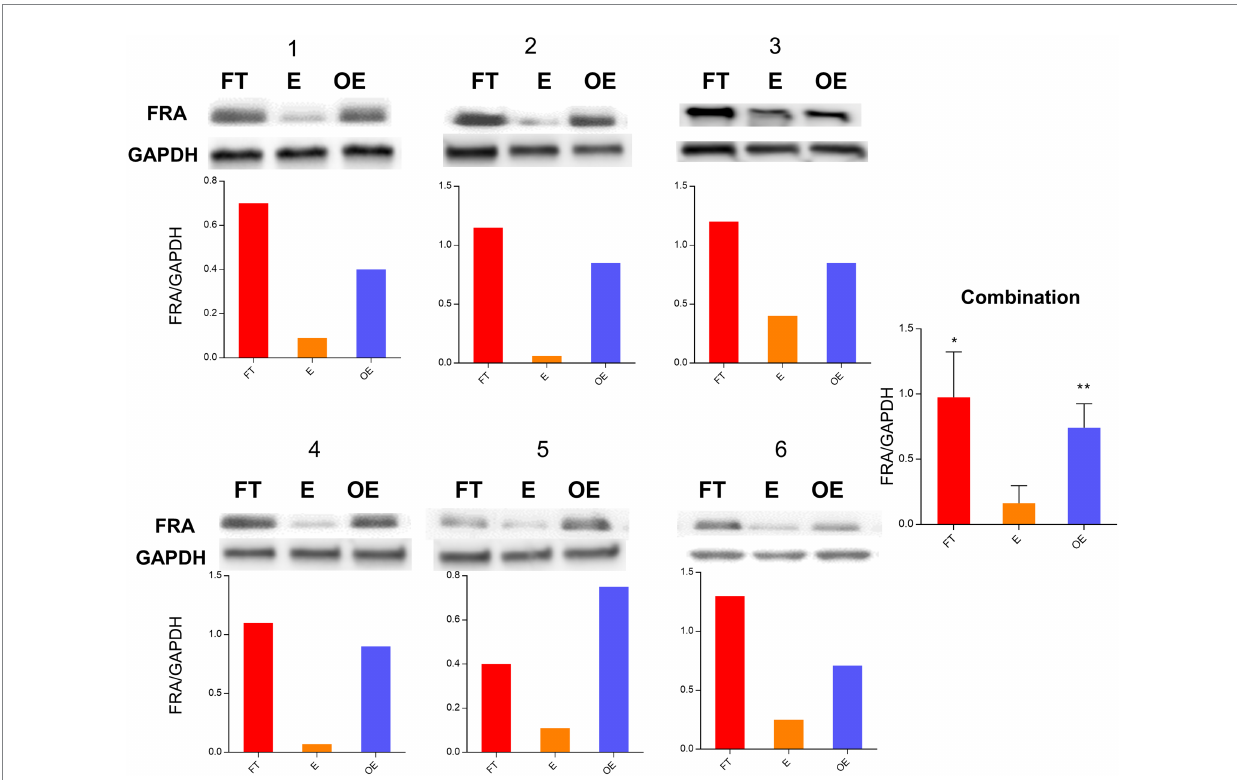
FIGURE 2 FRA protein expression level in paired tubal, endometrial, and ovarian endometriosis samples. Comparisons of protein expression levels of the fallopian tube (FT), the endometrium (E), and the foci of ovarian endometriosis (OE) by Western blot analyses. The figure shows the data from 6 paired samples with number labeled on the top of each panel. The FRA and GAPDH control bands are presented on the top, while the ratio of FRA/GAPDH is illustrated in the bottom for all 6 paired samples. The pooled data are summarized on the right side of the figure. Similar to the gene expression levels, FRA protein was significantly higher in the fallopian tube and the ovarian endometriosis samples than that in the endometrium [* p = 0.103 (FT vs. OE) and ** p = 0.001 (E vs.